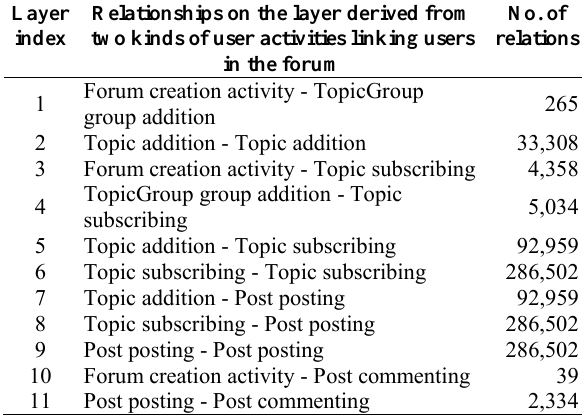
Table 3. The number of relationships in layers within the